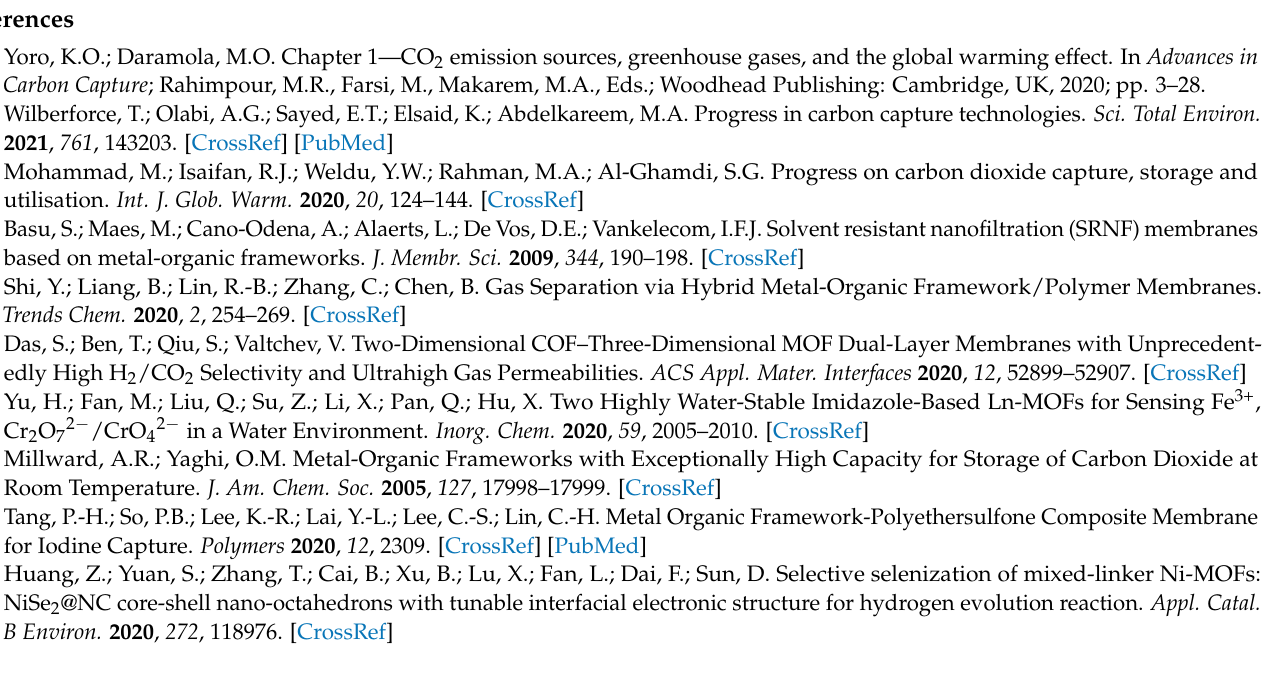
with the calculated PXRD patterns, Figure S2: UiO-66 N 2 isotherm, Figure S3: UiO-66 pore size distribution, Figure S4: UiO-66 CO 2 isotherm, Figure S5: UiO-66-NH 2 N 2 isotherm, Figure S6: UiO-66- Figure S9: MIL-68(Al) pore size distribution, Figure S10: MIL-68(Al) CO 2 isotherm, Figure S11: MIL- 100(Fe) N 2 isotherm, Figure S12: MIL-100(Fe) pore size distribution, Figure S13: MIL-100(Fe) CO 2 isotherm, Figure S14: A520 N 2 isotherm, Figure S15: A520 pore size distribution, Figure S16: A520 CO 2 isotherm, Figure S17: TGA curve of ZIF-8, Figure S18: TGA curve of UiO-66, Figure S19: TGA curve of UiO-66-NH 2, Figure S20: TGA curve of A520, Figure S21: TGA curve of MIL-68(Al), Figure S22: TGA curve of MIL-100(Fe), Figure S23: PXRD pattern of (a) P-UiO-66, (b) P-UiO-66-NH 2 , (c) P-A520 (d) P-MIL-68(Al), (e) P-MIL-100(Fe), Figure S24: Neat PEBAX SEM image, Figure S25: P-Z1 SEM image, Figure S26: P-Z3 SEM image, Figure S27: P-Z5 SEM image, Figure S28: P-Z8 image, Figure S29: P-Z10 image, Figure S30: P-Z20 image, Figure S31: P-Z30 image, Figure S32: TGA curve of Pebax/5 wt% MOF MMMs and neat Pebax, Table S1: N 2 Adsorption, Table S2: CO 2 Adsorption, Table S3: PEBAX/n wt% ZIF-8 MMMs gas separation efficiency, Table S4: PEBAX/5wt% MOF GPA measurement, Figure S33: The gas permeability and gas separation selectivity of Pebax/ZIF-8 MMMs in the